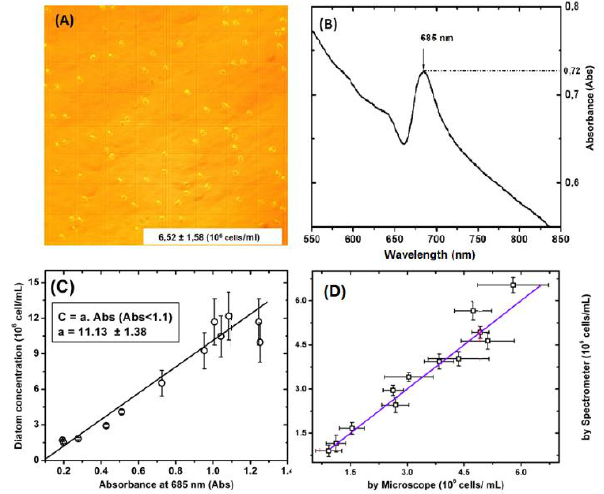
Fig. 6. Micrograph (A) and absorption spectrum at [550 nm – 850 nm] region of the Chaetoceros sp. containing sample at 6.52 × 10 6 cells/mL concentration. The dependence of diatom concentration on the absorbance at 685 nm (C) and the correlation between the concentrations measured by spectrophotometer and by microscope at the range from 1.2×10 6 to 6×10 6 cell/mL